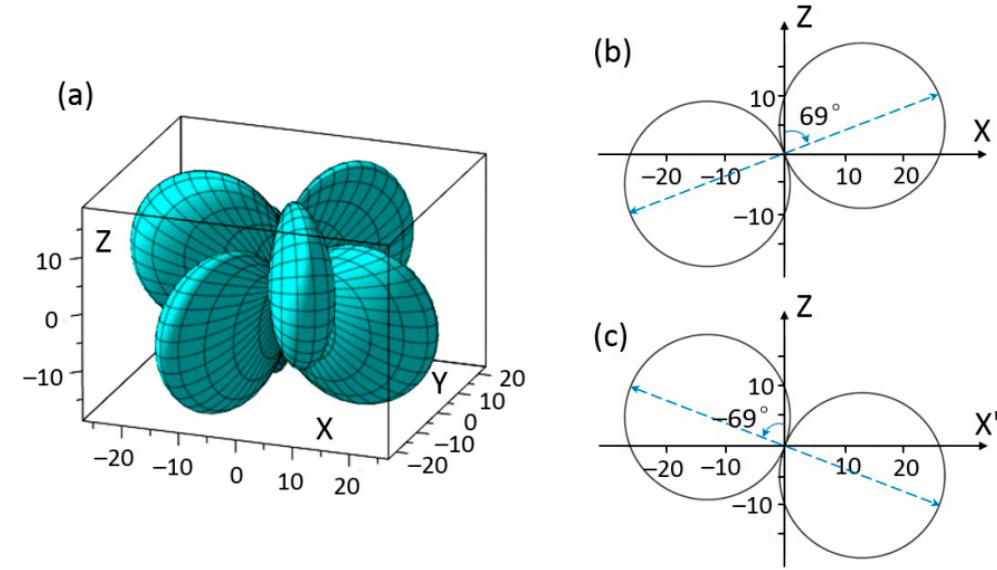
Table 1. Comparison of elastic stiffness c ij ′ (GPa) and piezoelectric constant d ij ′ (10 − 12 C/N) and their extremums along chosen orientations among BiFeO 3 ( 3m ), tetragonal BaTiO 3 ( 4mm ), and KNbO 3 ( m2m ) [28,29] # .